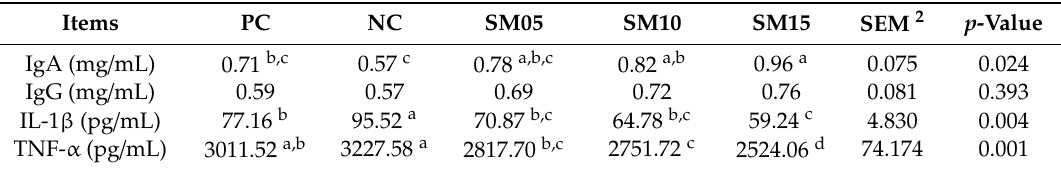
Table 5. E ff ect of spent mushroom ( C. militaris ) on immunity and inflammatory responses in weaning pigs 1 .